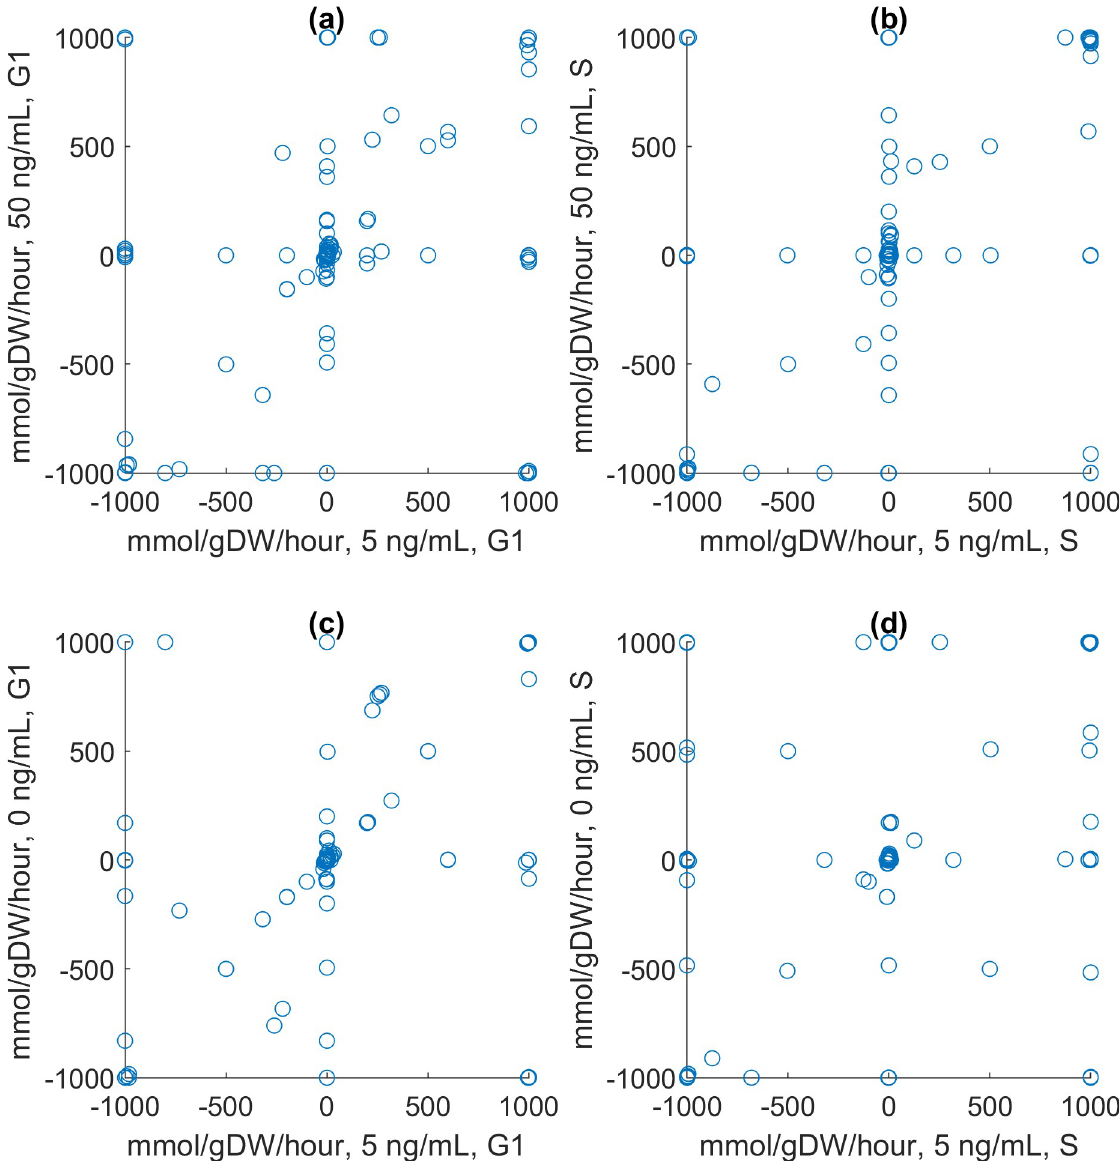
Fig 5. Representative results from the constraint-based models. Details about how the molecular models were used on their own can be found in Methods and S1 Text. Scatter plots comparing the metabolic fluxes in a Th0 cell during different cell cycle phases (G1 and S) at different IL2 concentrations (0, 5, and 50 ng/mL). 5 ng/mL is the baseline concentration. (a) 5 and 50 ng/mL, G1. (b) 5 and 50 ng/mL, S. (c) 0 and 5 ng/mL, G1. (c) 0 and 5 ng/mL,